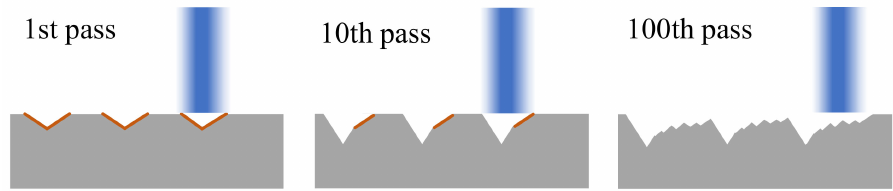
Figure 15. Schematics of the PLG mechanism at a pulse pitch of 20 µ